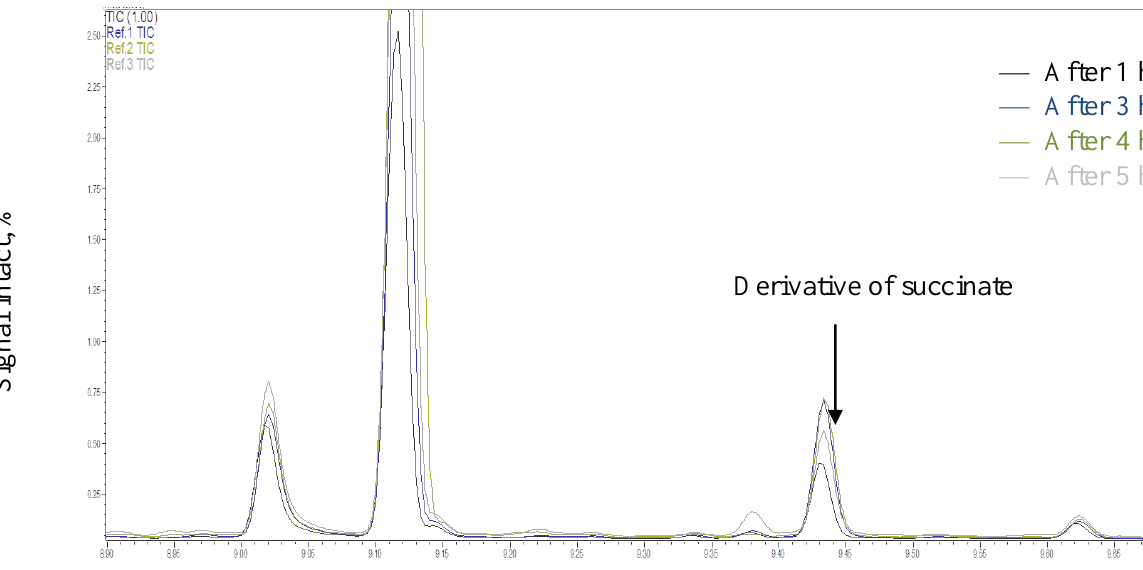
Fig. 3. Succinate standard chromatogram after derivatization at 70 °C temperature